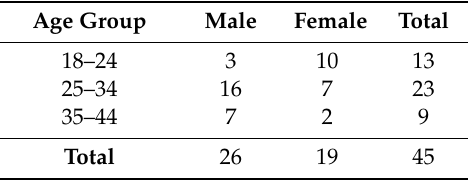
Table 14. Participants split by age group and gender.